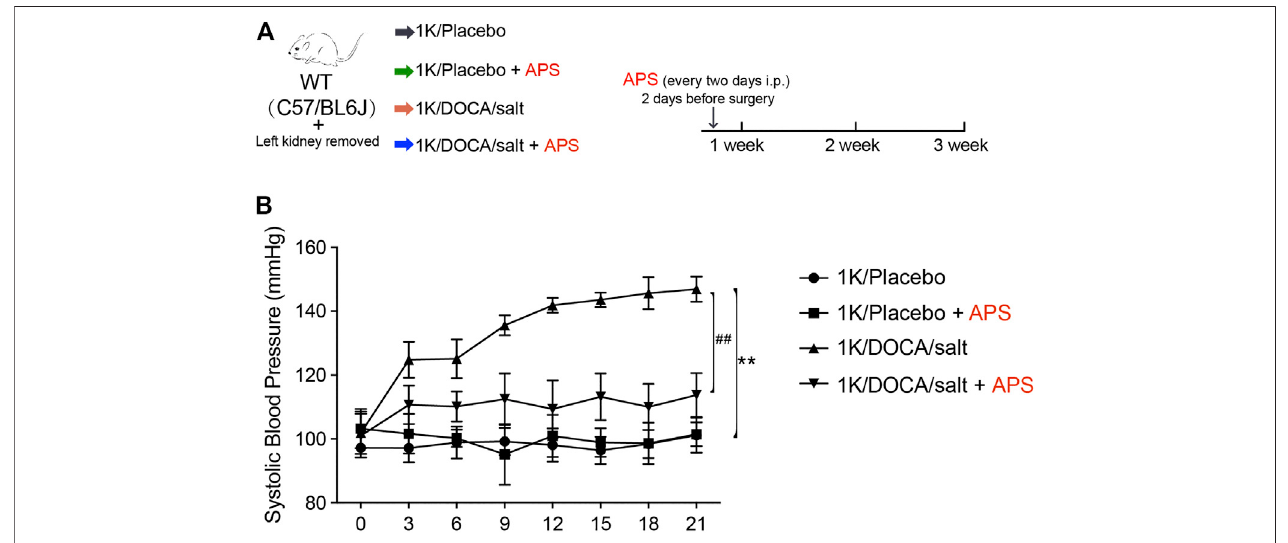
FIGURE1| TreatmentwithAPSpreventsDOCA-inducedhypertension. (A) Diagrammaticrepresentationoftreatmentofdifferentgroupsofmice:1K/placebo,1K/ placebo + APS, 1K/DOCA/salt, and 1K/DOCA/salt + APS. (B) Average systolic blood pressure of each group before and after DOCA treatment obtained by telemetry ( n (cid:1) 6 per group). ** P < 0.01 versus control mice. ## P < 0.01 versus DOCA + APS